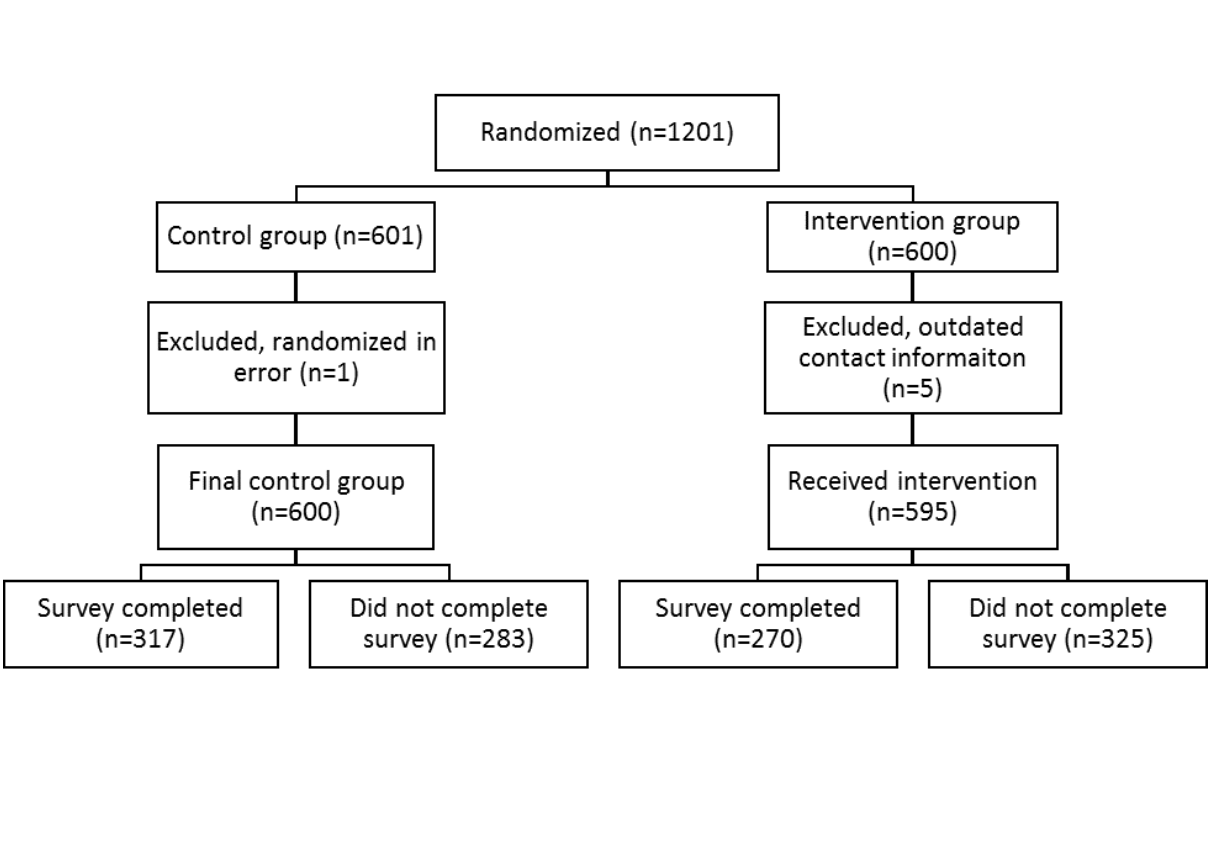
Figure 1. CONSORT